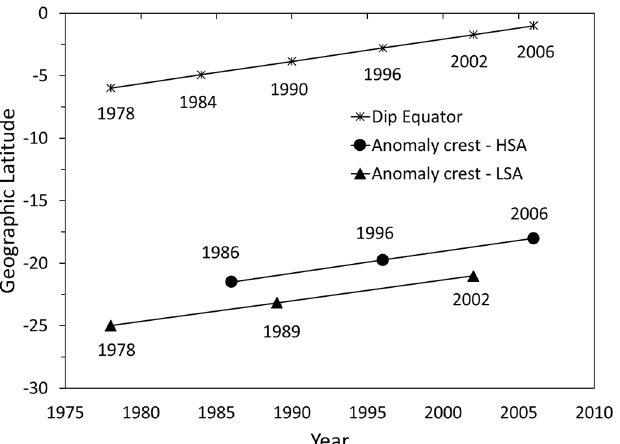
Figure 11. Time variation of the geographic latitude of the EIA crest at the southern hemisphere, over the 45° W meridian high solar activity (HSA) (triangles) and low solar activity (LSA)(circles). The time variation of the geomagnetic equator position at the same longitude is also shown (stars). (Adapted from Batista et al. [83]: Figure 8).